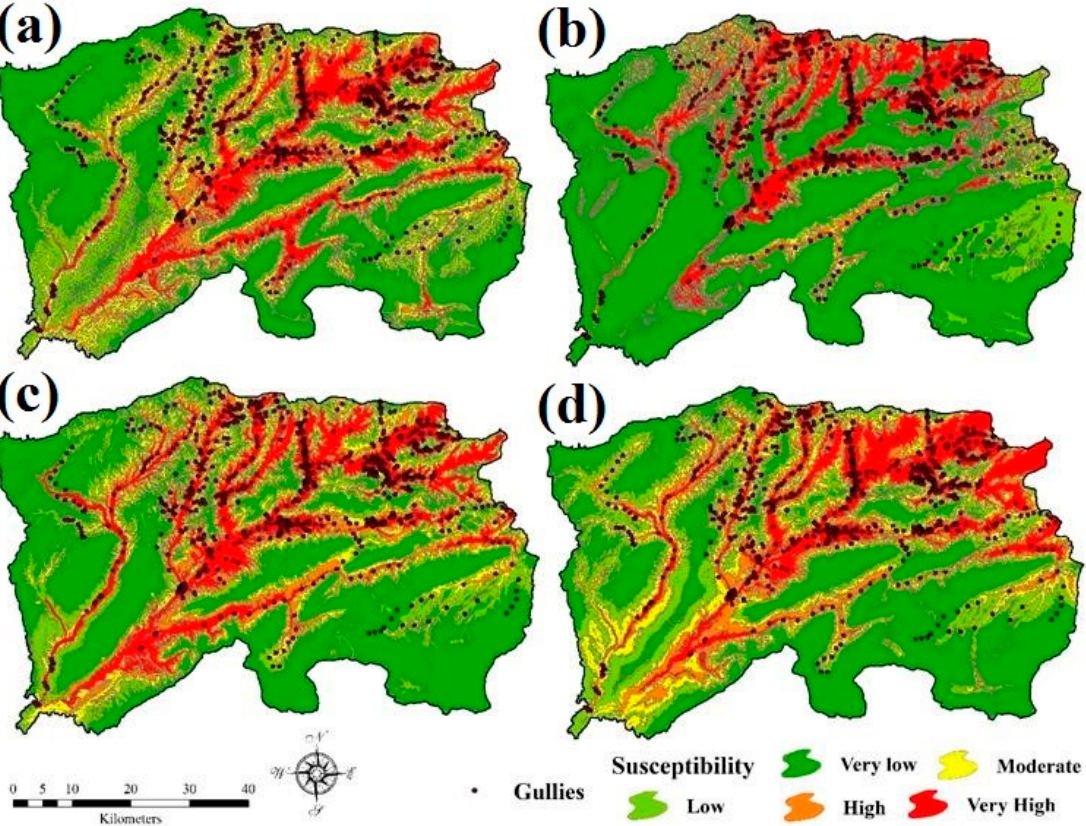
Figure 5. Gully erosion susceptibility mapping using individual models: ( a ) maximum entropy (MaxEnt), ( b ) artificial neural network (ANN), ( c ) support vector machine (SVM), and ( d ) general linear model (GLM).